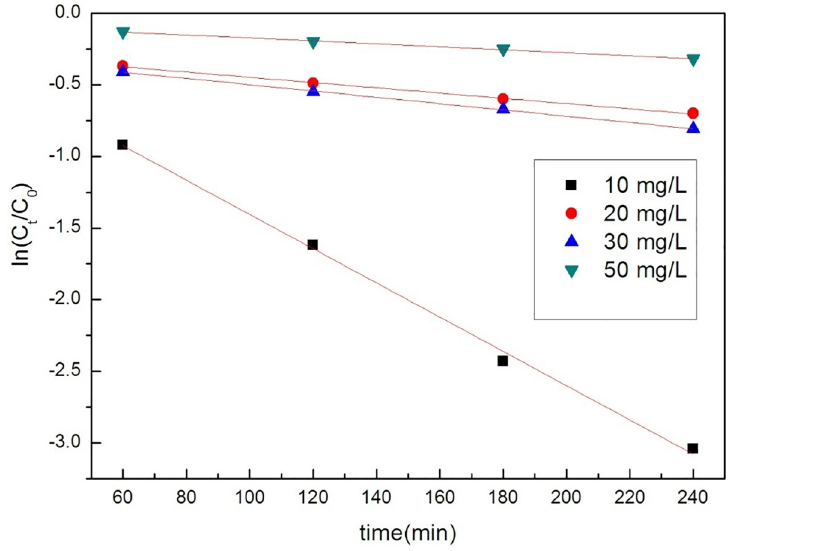
Fig 6. The Pseudo-first-order kinetic model of GO/MOFs on TC.